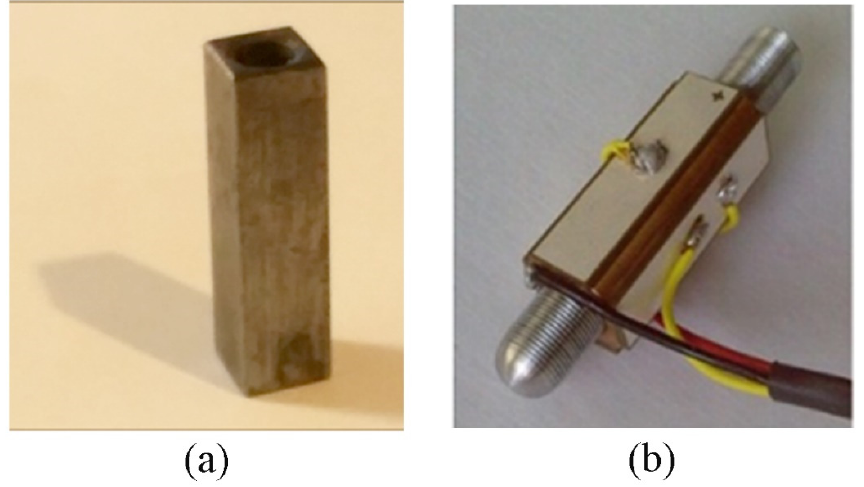
Figure 1. A diagram of ( a ) a stator having a 30 mm × 8 mm × 8 mm cuboid shape with an inner diameter of 4 mm for the hollow cylinder and ( b ) a squiggle motor with a threaded output shaft and four piezoelectric plates with 30 mm × 8 mm × 1 mm (thickness) being affixed the stator. The diam- eter and length of the threaded shafts were 4 mm and 75 mm, respectively.